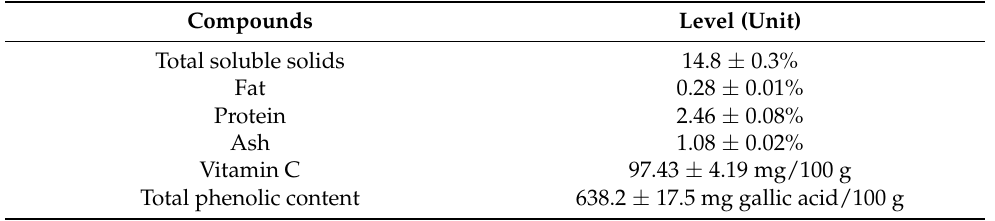
Table 1. Chemical composition of